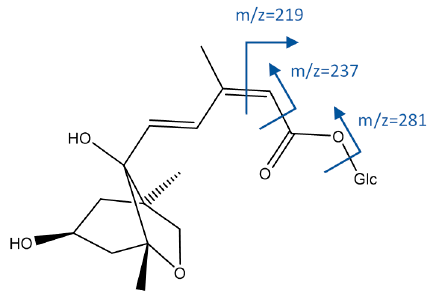
Figure 6. Structure and fragments of acid derivatives (1), (16), and (33).